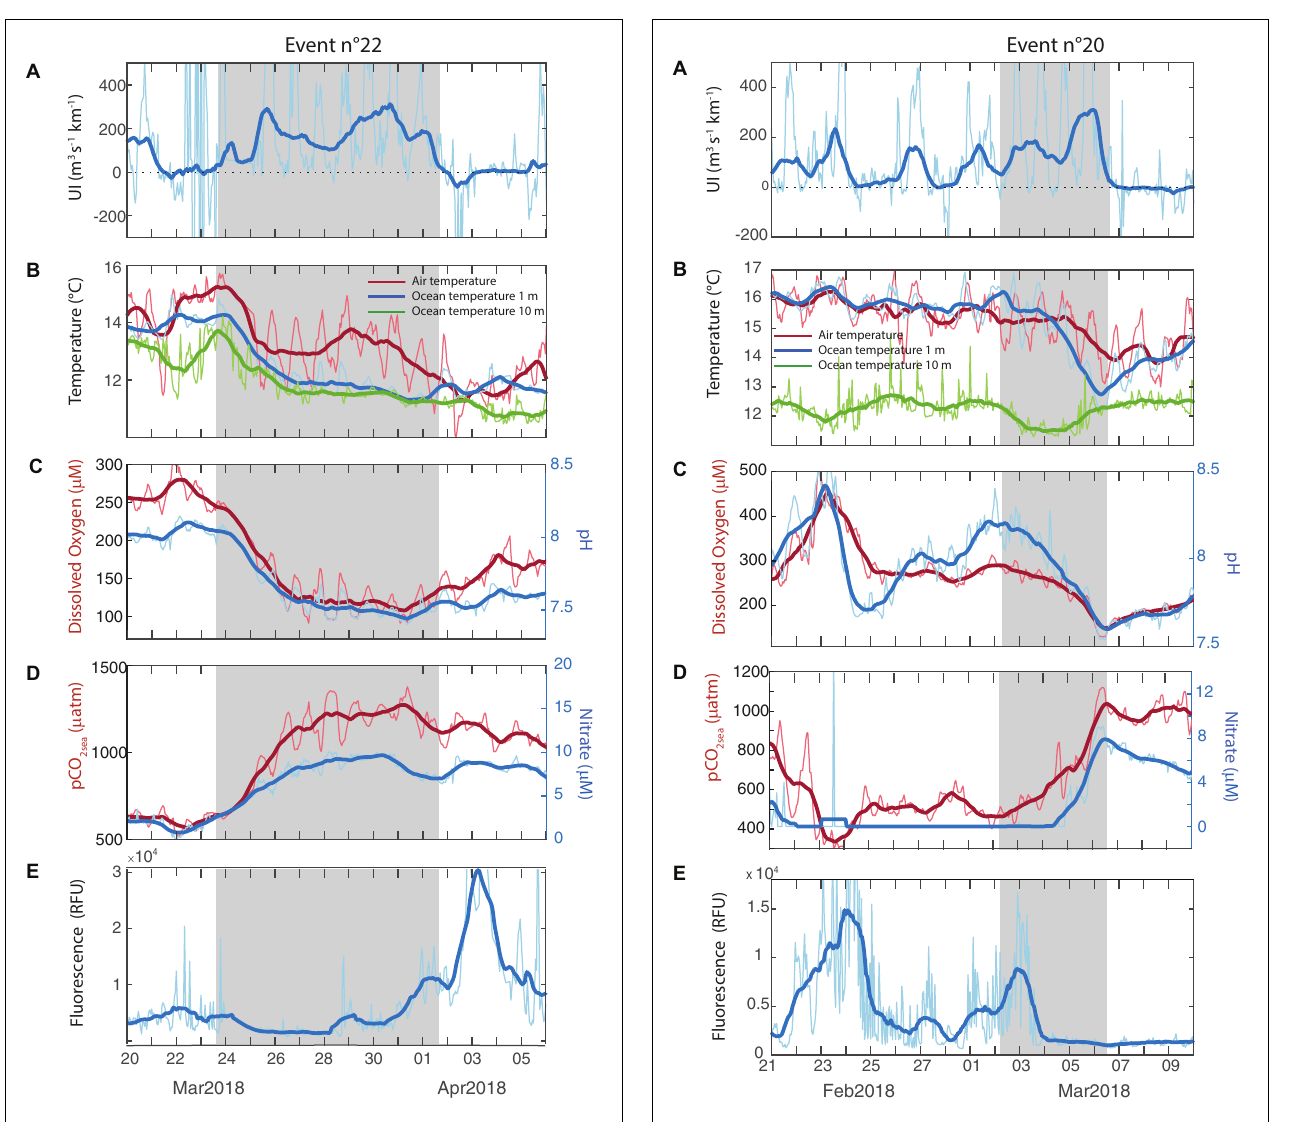
12 h after the onset reaching an anomaly of − 50 µ M (relative to time 0) 2 days after the upwelling event onset. The NO 3